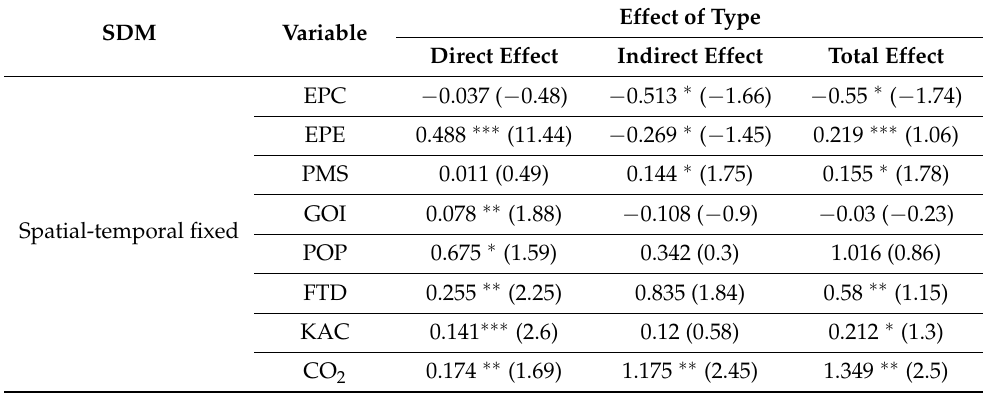
Table 12. The spatial spillover effect by the spatial-temporal fixed-effect model with W S